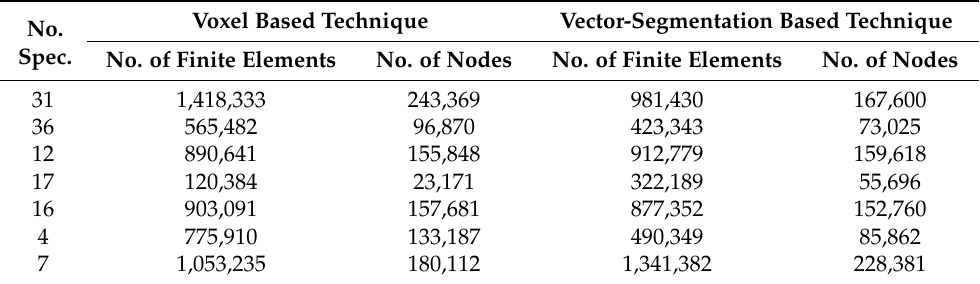
Table 5. FE-model sizes for different